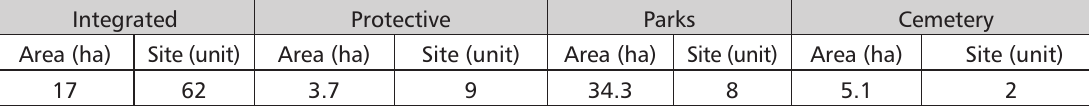
The distribution, by area and units, of different categories of green space Integrated Protective